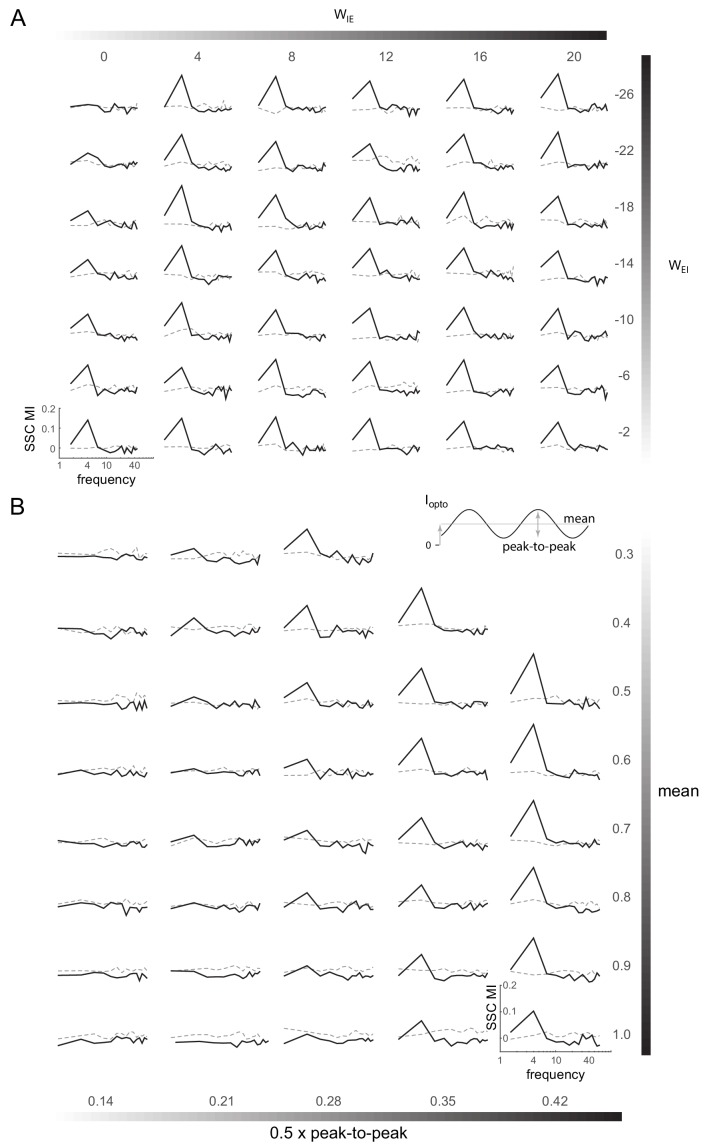
Induction of coherent activity in the E-I model is robust across network and stimulation parameters - II.(A) Spike-spike coherence modulation index (SSC MI; see Figure 6D) as a function of varying the cross-coupling parameters Wie and Wei, keeping the other two parameters fixed (Wee=16,Wii=-1). (B) SSC MI as a function of the mean and peak-to-peak variation of the 4Hz sinusoidal optical stimulation (Iopto). Network parameters same as in Figure 6.